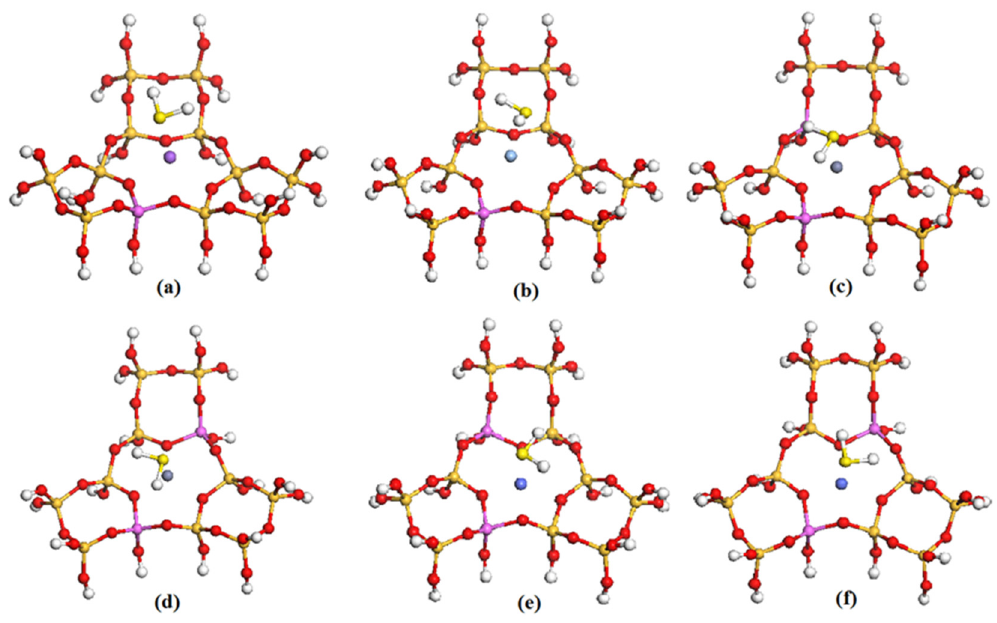
Figure 5. Adsorption configurations of H 2 S on ( a ) NaX, ( b ) AgX, ( c ) ZnX(i), ( d ) ZnX(ii), ( e ) CoX(i), and ( f ) CoX(ii) cluster models. (Red: O, orange: Si, white: H, pink: Al, yellow: S, purple: Na, blue: Ag, grey: Zn, dark blue: Co.) Reprinted with permission from Ref. [58]. 2018, Elsevier.